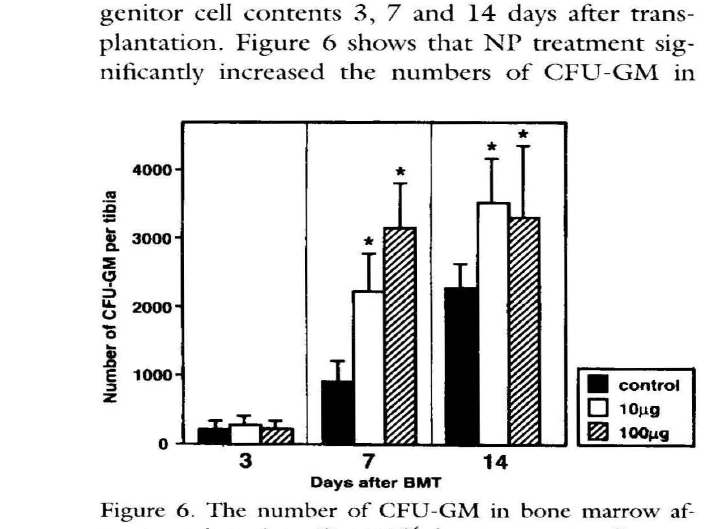
Figure 6 . The number of CFU-GM in bone marrow af ter transplantation. One x 10 6 bone marrow cells were transplanted with or without NP and the changes in the number of CFU -GM in bone marrow was investigated. Each bar represents the mean ± SD obtained from five mice individually analyzed. *Significant increase (p<O.OS ) \\ith respect to NP non-treated